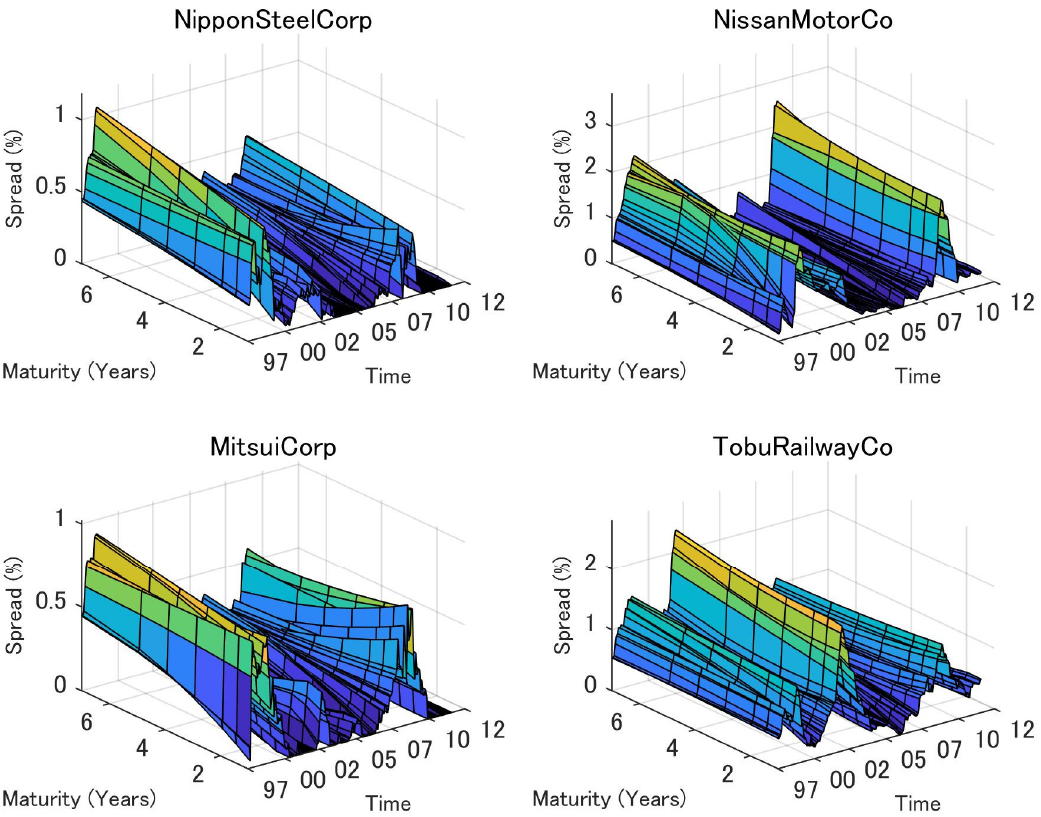
Figure 1. Credit spreads across companies and time. Note: Time series of the term structure of credit spreads of 4 of the selected 26 names.